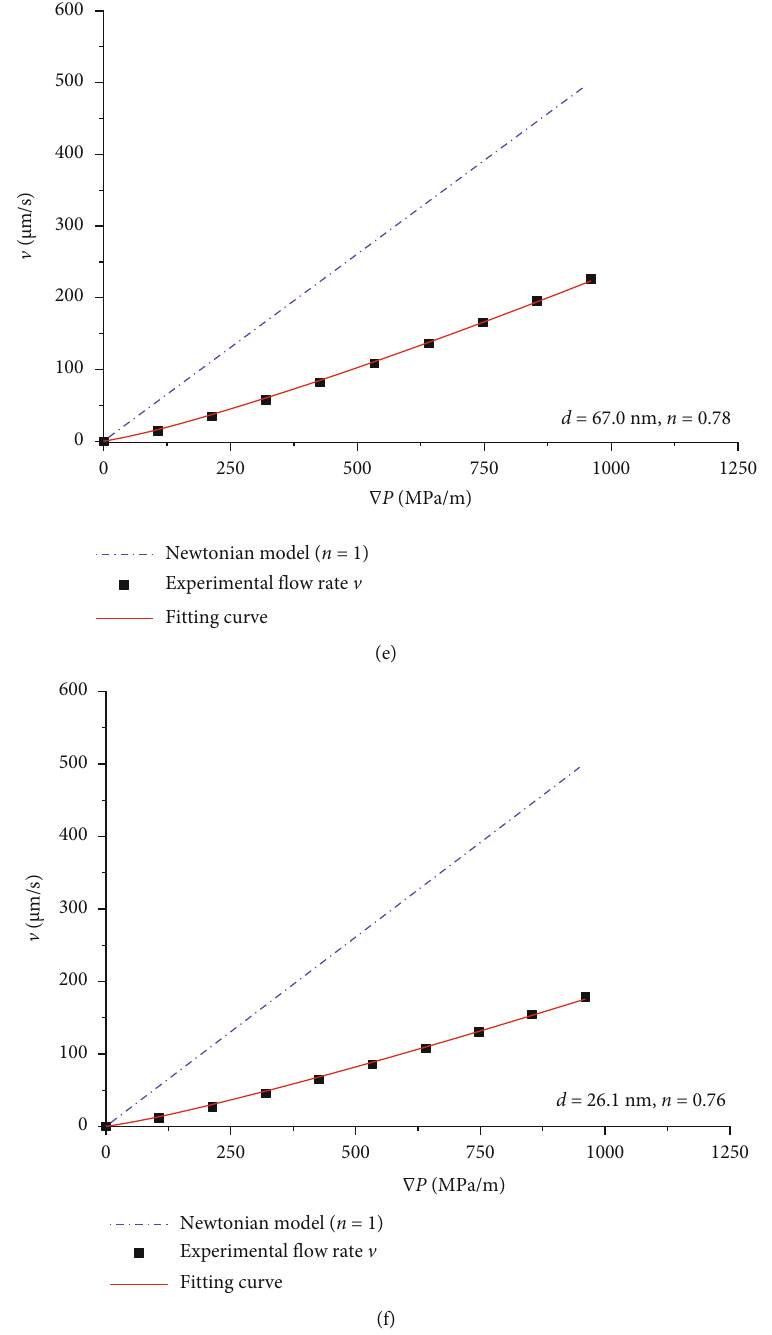
Figure 5: Experimental curves of water fl ow in micro- nanochannels with di ff erent